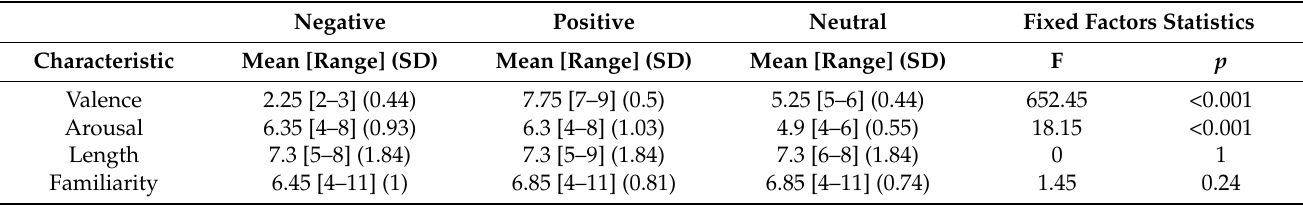
Table 1. Stimulus statistics with mean, range and standard deviation (SD) for negative, neutral and positive words employed; valence, arousal, length and familiarity from ANEW-I database (Bradley and Lang, 1999). Negative Positive Neutral Fixed Factors Statistics